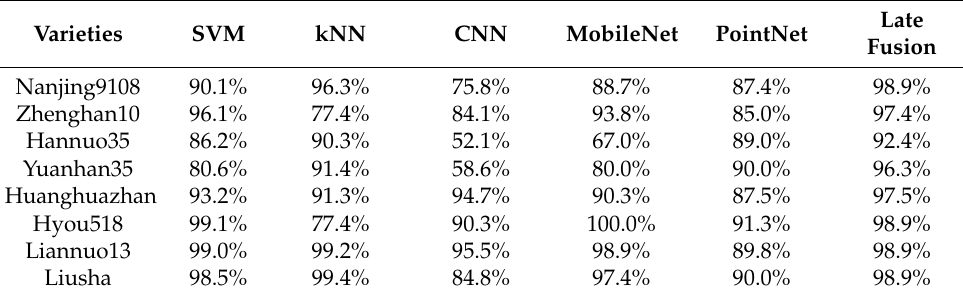
Table 3. Accuracy comparison for identification of various rice